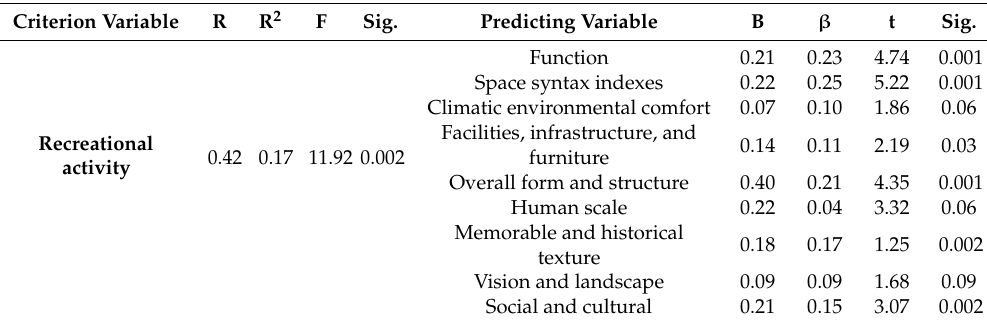
Table 8. Results of regression analysis test for predicting recreational activity.